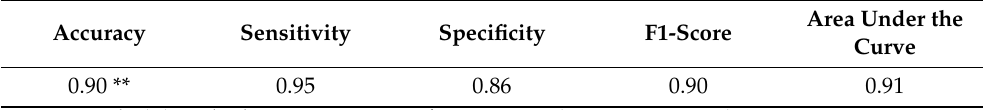
Table 2. Classification Performance Results.